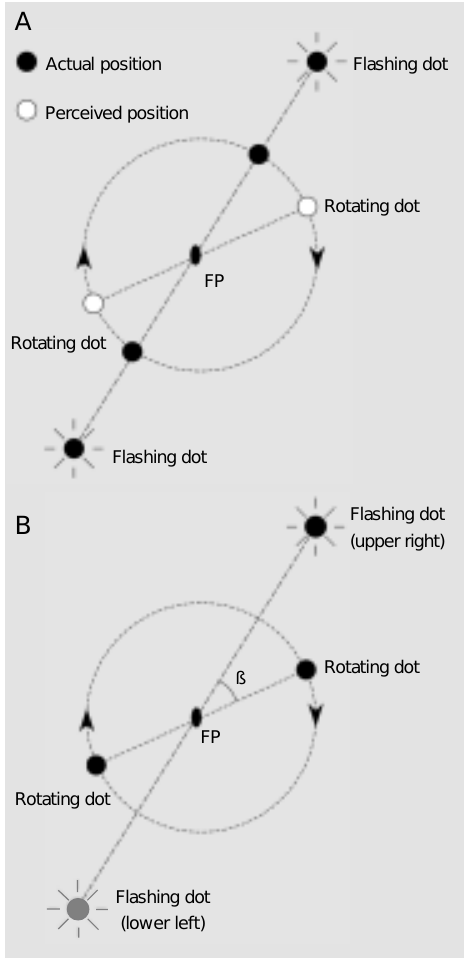
Figure 1. A , The perceptual mis- alignment between moving and flashing stimuli (flash-lag effect) as reported by most observers. The rotating dots, moving around the fixation point (FP), are seen ahead of the flashing dots when the latter are flashed in perfect alignment with the former set of dots. B , The visual stimuli uti- lized in all three experimental situations. Two rotating dots 2